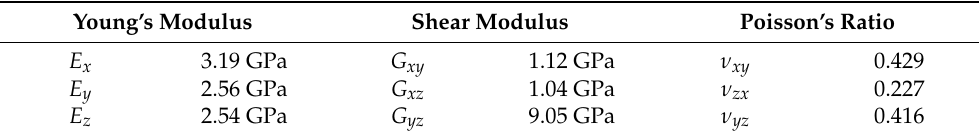
Figure 6. Photos of test pieces in different directions. Table 4. Material constants of orthotropic